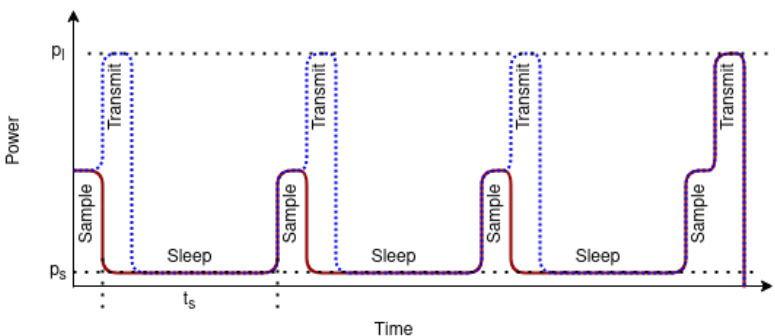
Figure 6. Energy savings by combining data in a single data frame.